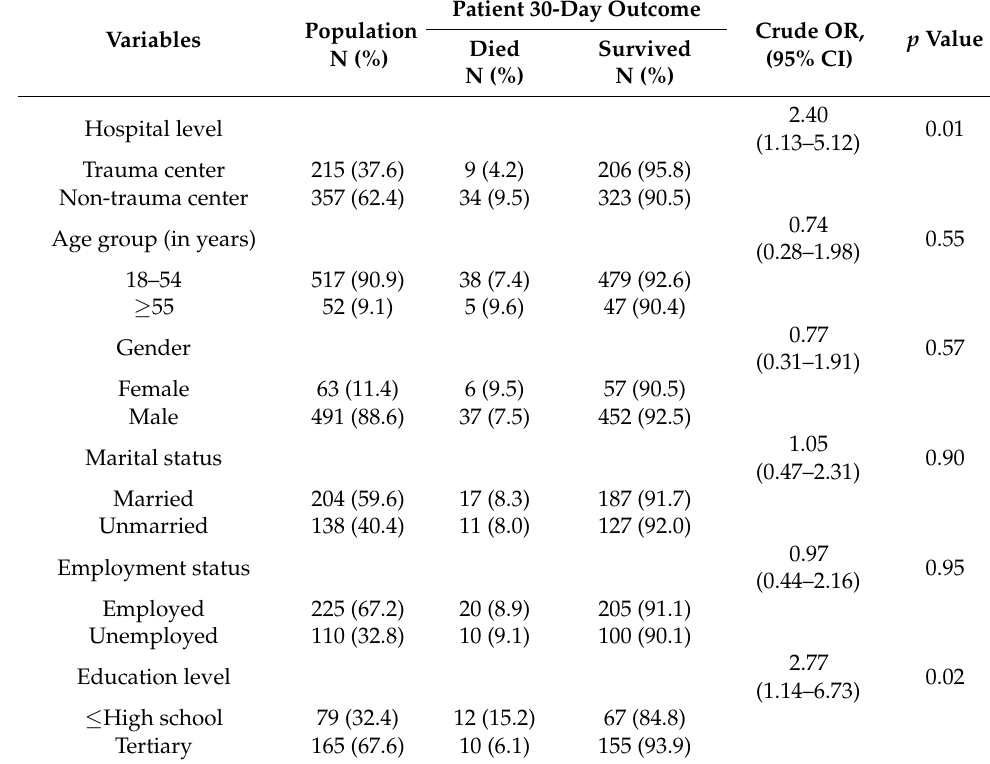
Table 5. Unadjusted risk ratios of road traffic mortality by patients and hospital